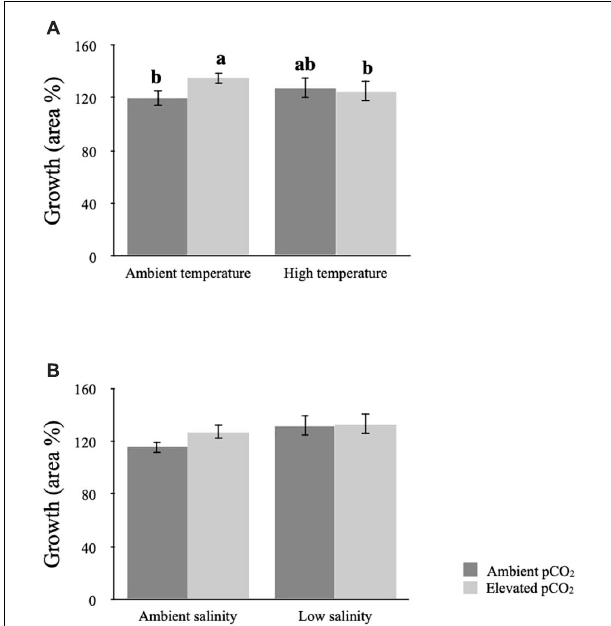
FIGURE 1 | Effects on growth measured as area in Fucus vesiculosus exposed to different levels of temperature (ambient and high, A ), salinity (ambient and low, B ), and pCO 2 (ambient and elevated) as fixed orthogonal factors. Letters denote statistically significant post-hoc groupings (SNK post-hoc test, p < 0.05). Values are means ± 95% CI, n = 20. Letters are missing in (B) because the interaction term was not statistically significant in the ANOVA ( p = 0.066).